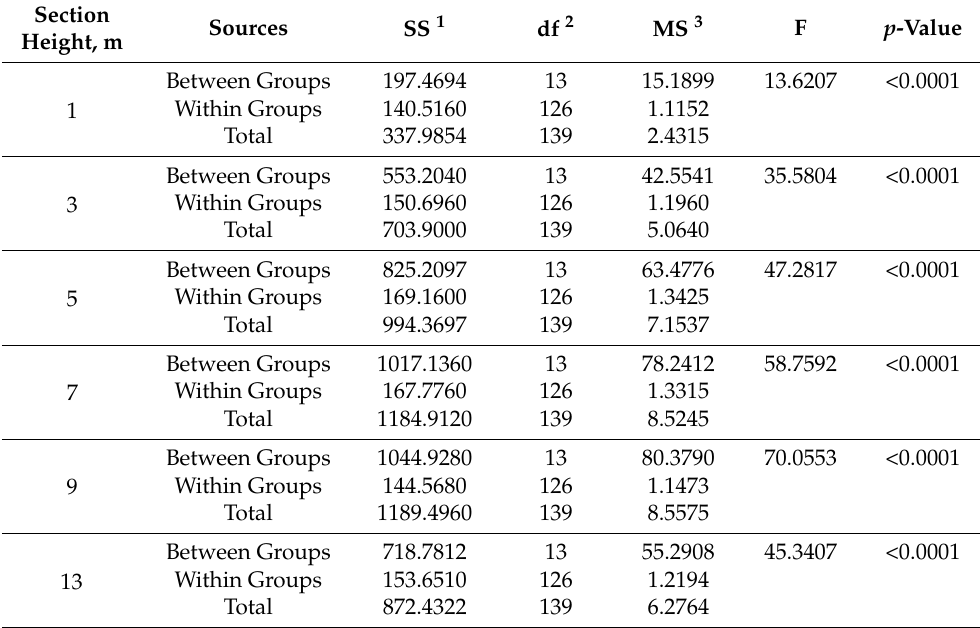
Table 2. ANOVA single factor applied to stem diameter measurements using laser caliper by many users for multiple readings at the same sections along the tree stem, α =